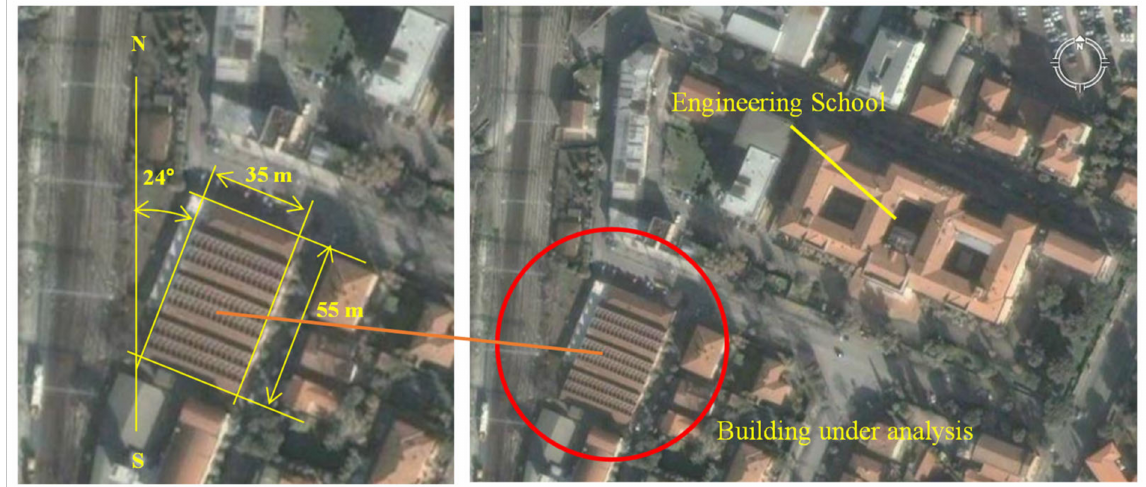
Figure 5. The building considered for testing the optimization method (an aerial view).